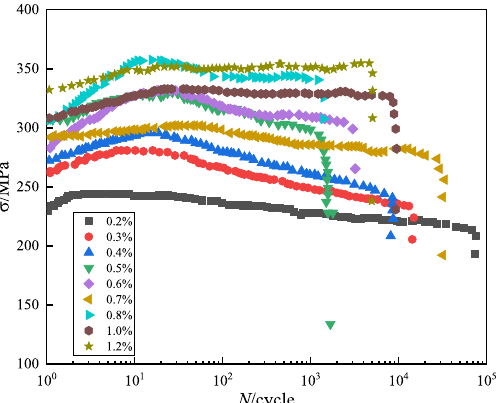
Figure 2. The relationship between stress and cyclic cycles under different strain